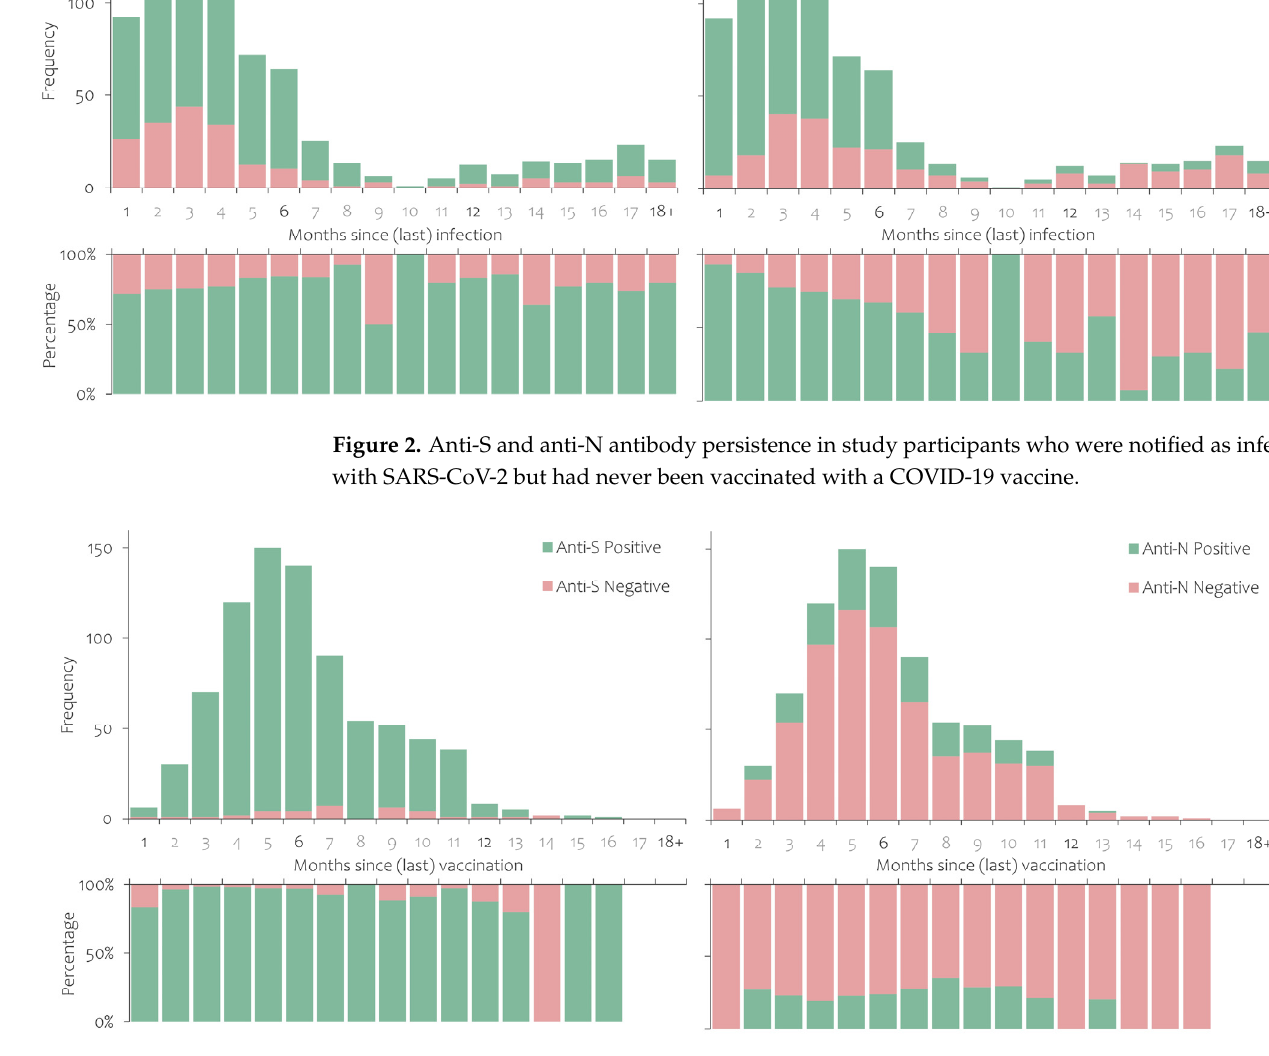
Figure 3. Anti-S and anti-N antibody persistence in study participants who had received at least one dose of a COVID-19 vaccine but without a notified SARS-CoV-2 infection.